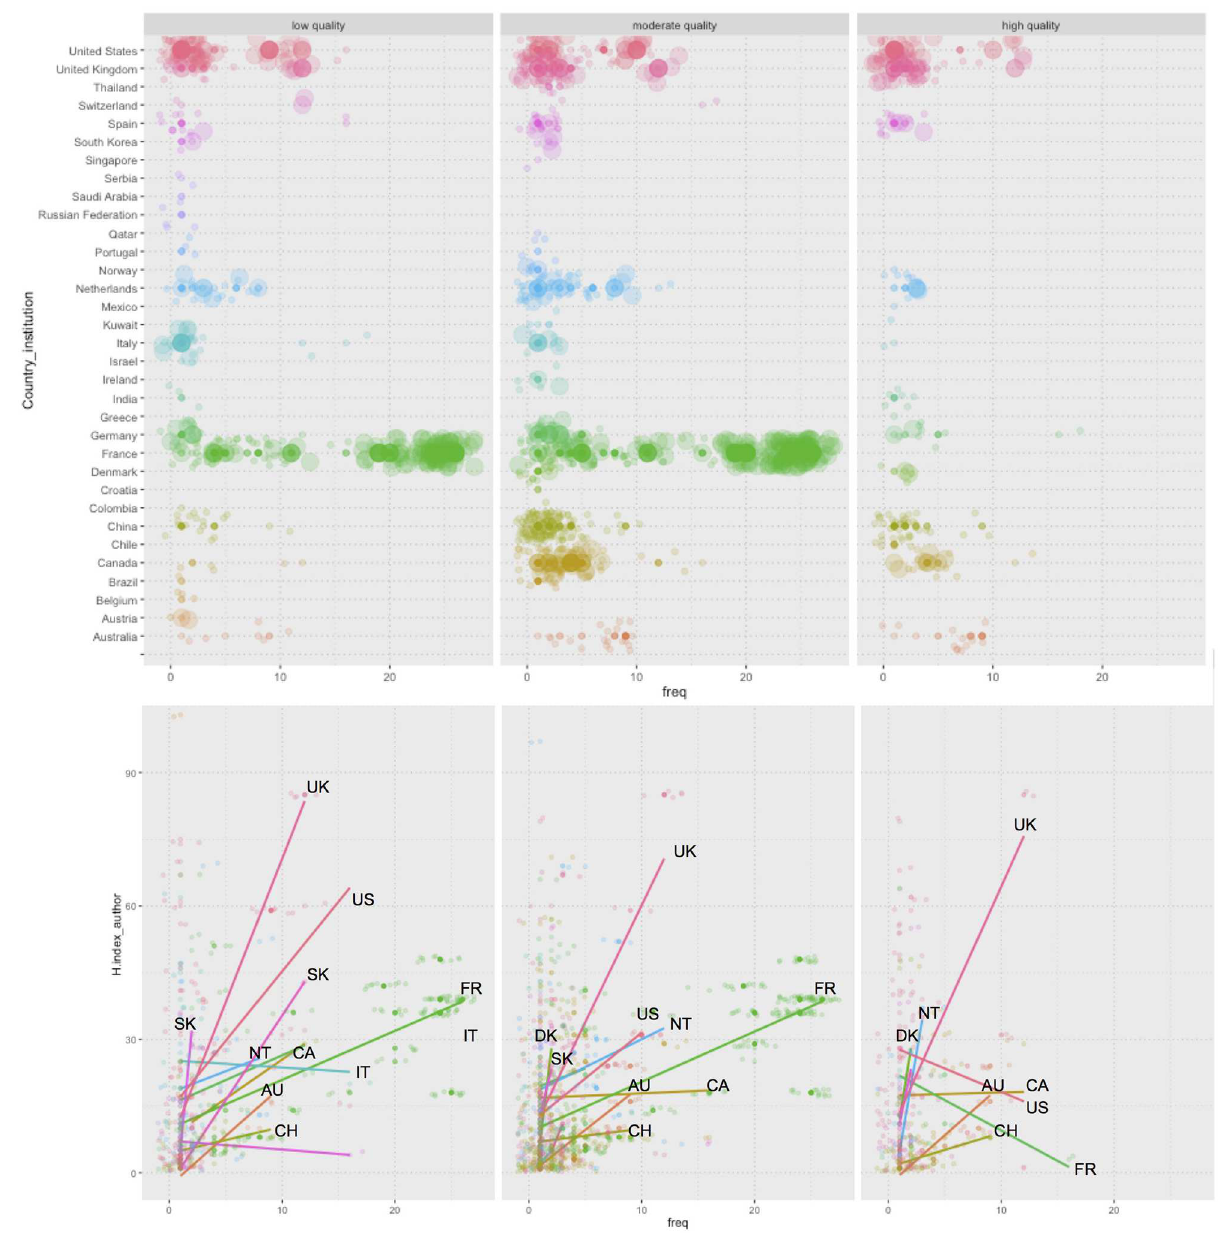
Fig 4. Influence of authors’ scientific quality and productivity on methodological quality of SRs and MAs about psoriasis. Panel (a-c): Bubbleplot that representsthe number of publicationsby author. Bubblesize is proportional to the author’sH-index. Authors are sorted by their institution’s country. Panel (d-f) representsa scatter plot of author’s H-indexvs. number of authored publications. Smoothed fitted lines represent predictionsusing linear regressionfor every country. Points and lines are coloredbased on author institutioncountry.